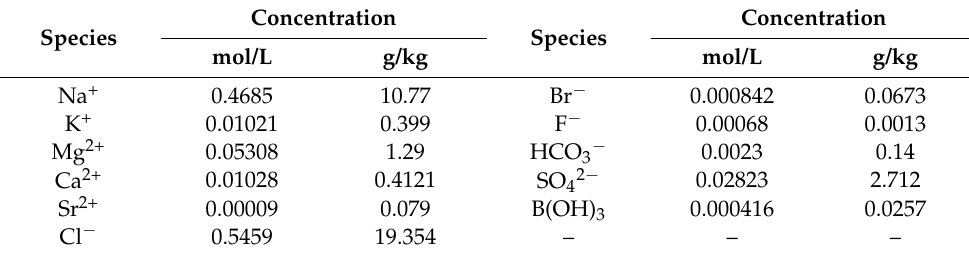
Table 2. Average chemical composition of the used natural seawater.